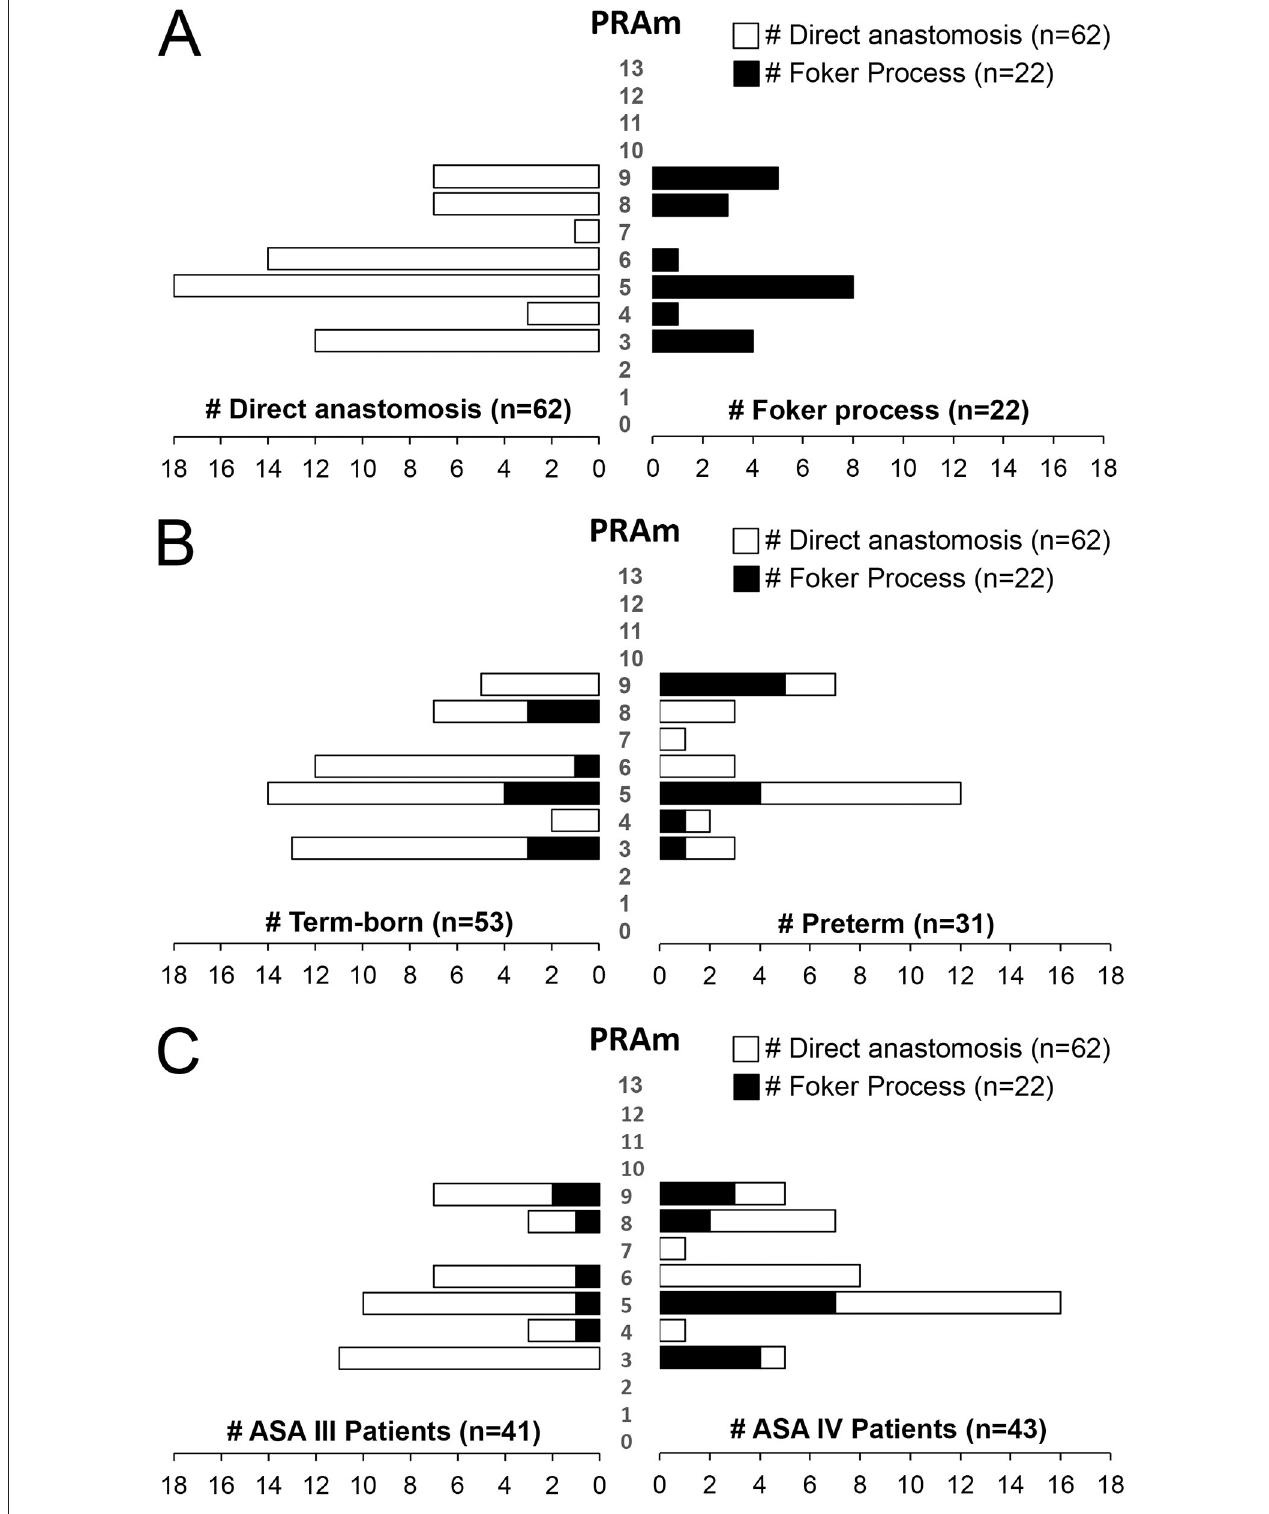
FIGURE 5 | Disease Severity Stratification of Infants Born with Esophageal Atresia by Type of Surgical Repair. (A) Illustrates wide distribution of Pediatric Risk Assessment (PRAm) scores (from scores 3–9) by the type of surgical repair: (i) direct anastomosis for short-gap esophageal atresia (EA) repair (left), and (ii) Foker process (5–8) for long-gap EA repair (right). (B) Summarizes severity of disease per type of surgical repair in relation to the gestation age at birth. Similar to data in Figure 4A , note the subtle tendency of term-born patients having had lower, and premature patients higher PRAm scores. When PRAm scores are graphed in relation to American Society of Anesthesiologists (ASA) physical status (C) , we report more infants with long-gap EA with an ASA IV classification (73%; 16/22).